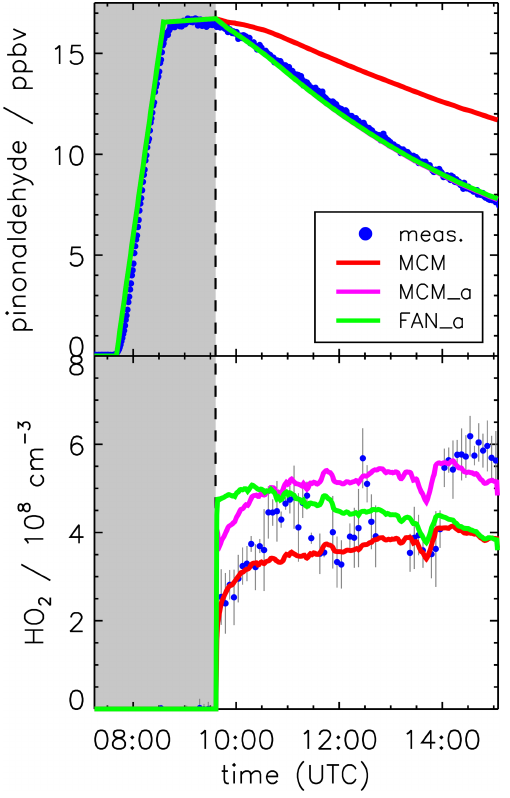
Figure 6. Pinonaldehyde and HO 2 time series during the exper- iment with OH scavenger. Model runs were done either using the MCM with parameterization of pinonaldehyde photolysis fre- quencies (MCM), with measured values for photolysis frequencies (MCM_a; see the text for details), or with modifications described in Fantechi et al. (2002) (FAN_a). The pinonaldehyde concentra- tion time profile is the same for both model runs MCM_a and FAN_a. Grey-shaded areas indicate times when the chamber roof was